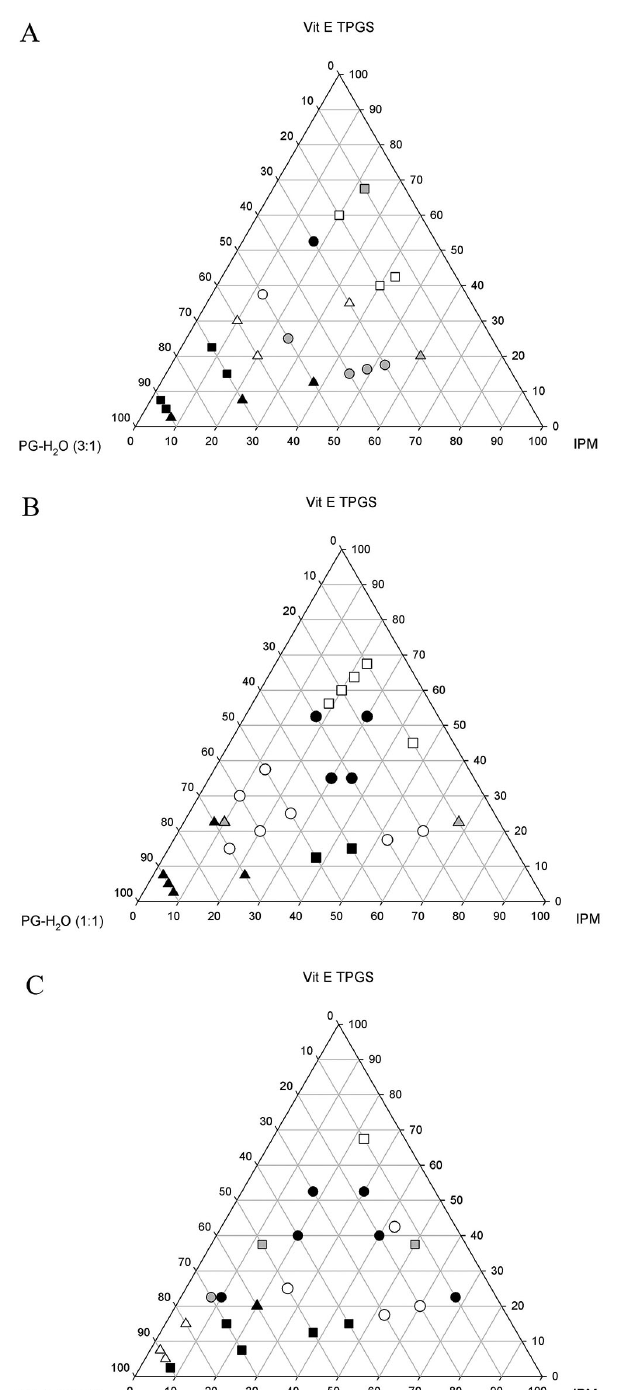
O 2 FIGURE 5 - Time-course of the in vitro skin penetration of nicotine incorporated into different formulations. The number of replicates is 4 per experimental group. *p < 0.05 compared to